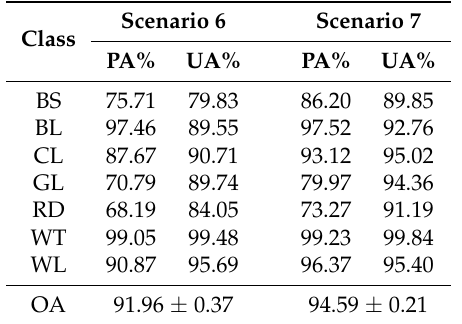
Table 6. Averaged PA and UA values per land cover class achieved from 30 random trials by using Random Forests classifier. The input feature scenarios derived from the fusion of SPOT-5 and LiDAR data.